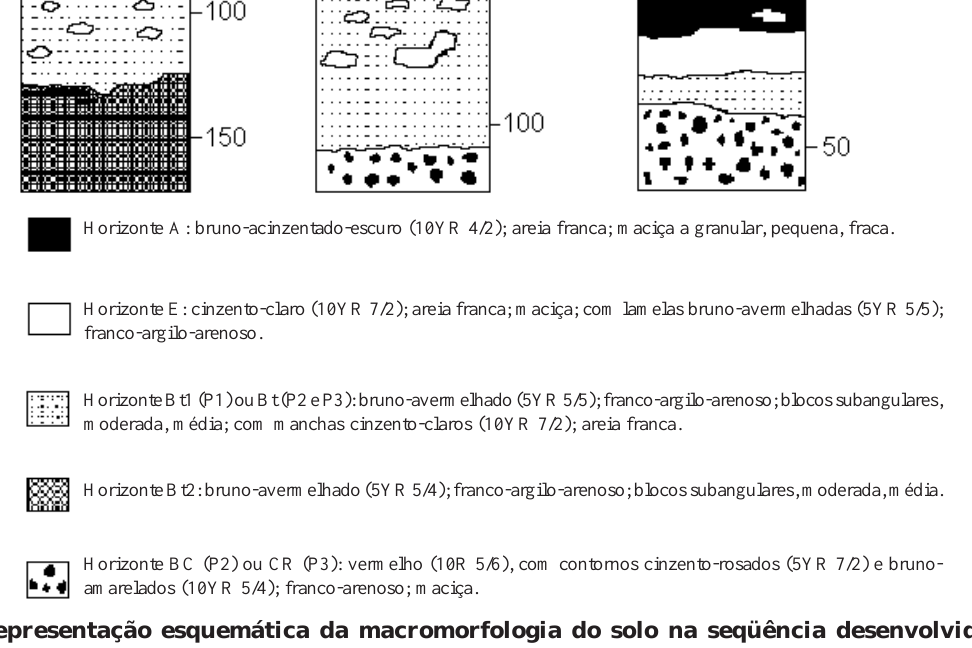
Figura 1. Representação esquemática da macromorfologia do solo na seqüência desenvolvida sobre